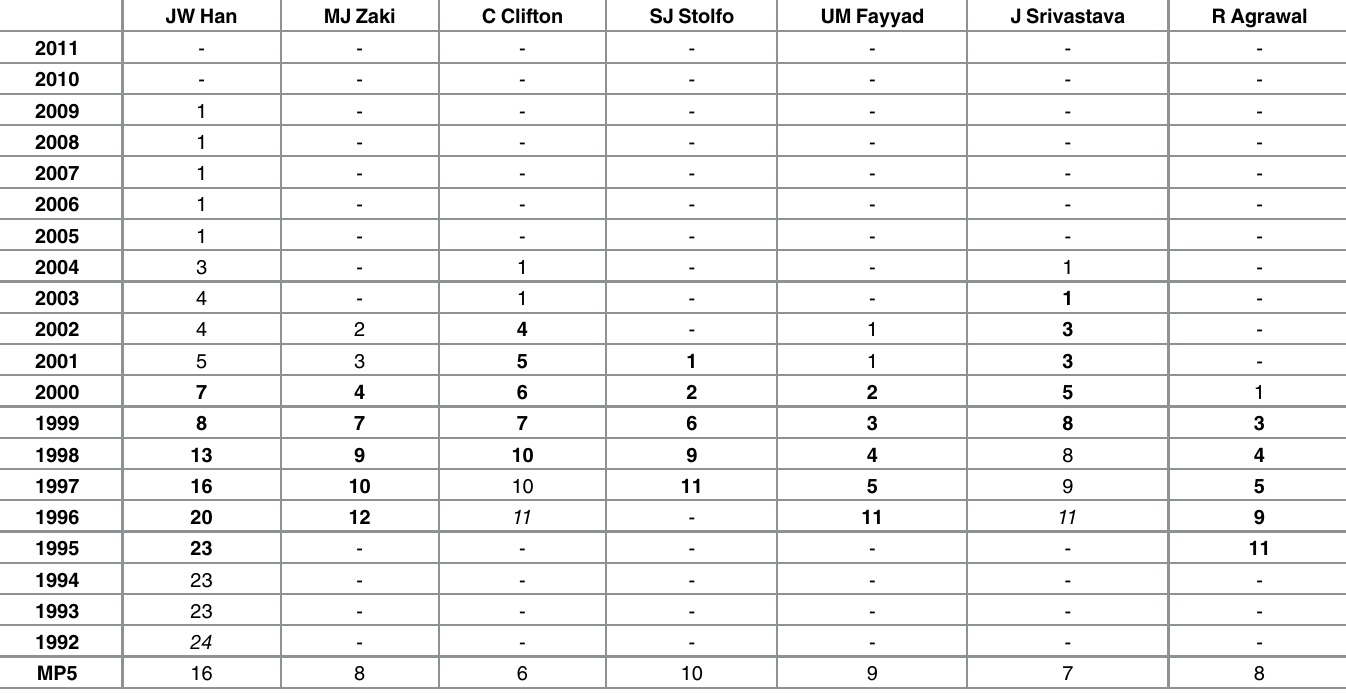
Table 5. The PR-index sequences and MP 5 of the top 7 authors based on the PR-index indicator. JW